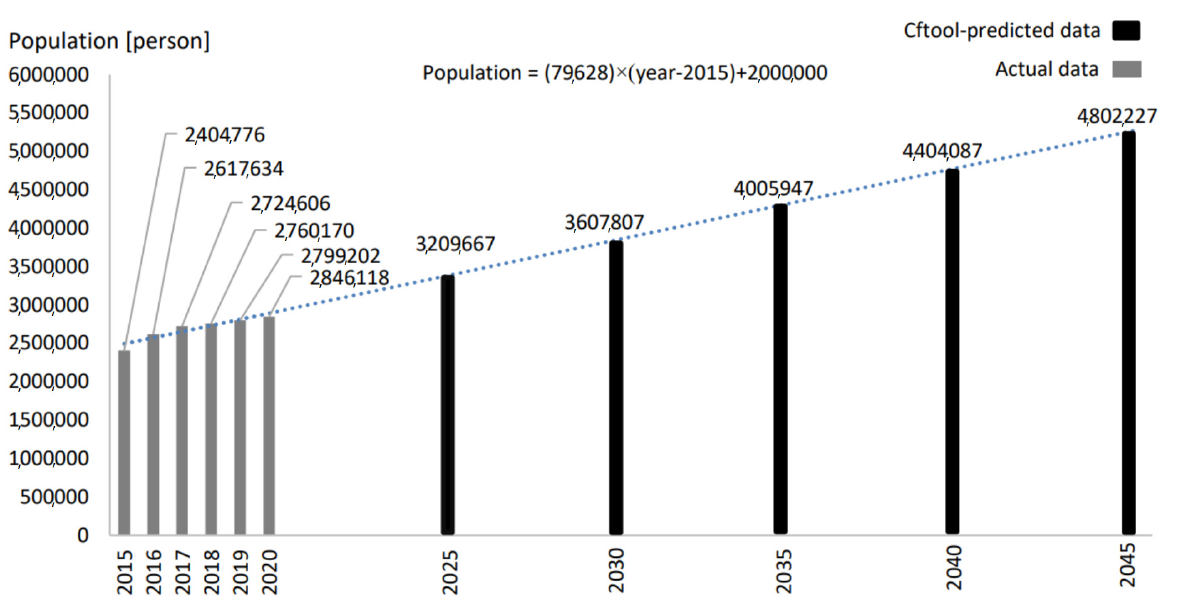
Figure 1. The actual population data (2015–2020) and the Cftool-projected population. Table 2. Local food supply in Qatar from 2016 to 2022